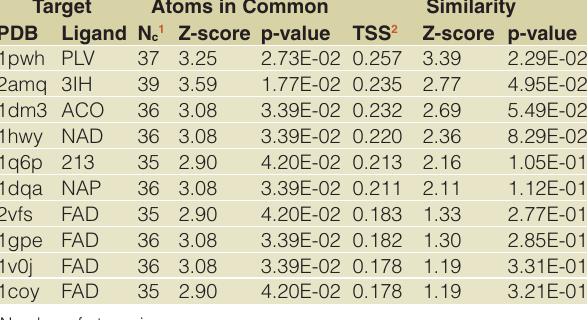
Table 2. IsoCleft Finder results for 2re3 sorted in decreasing order of Tanimoto Score of Similarity. Target Atoms in Common Similarity